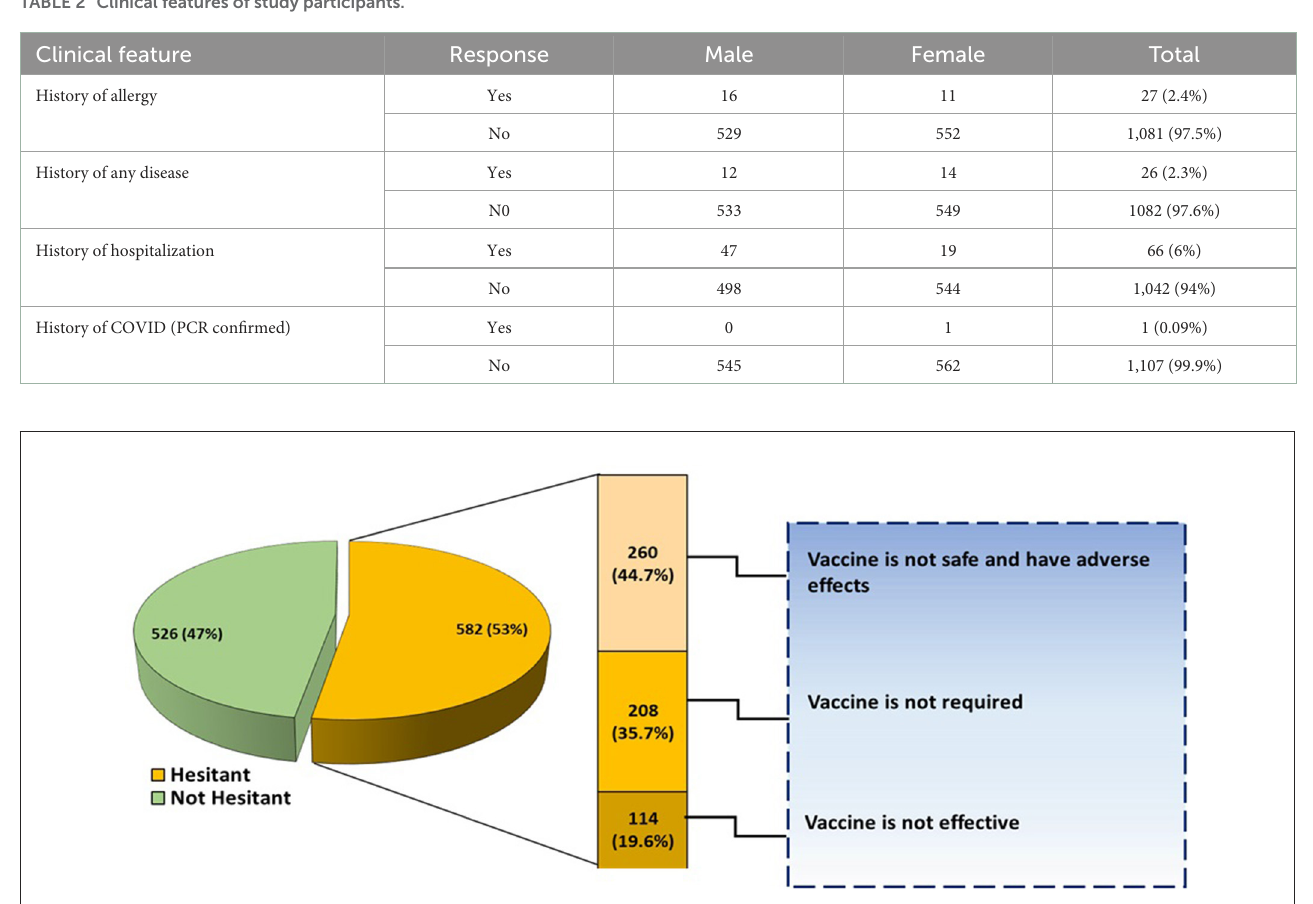
FIGURE2 Willingness of participants to get the COVID-19